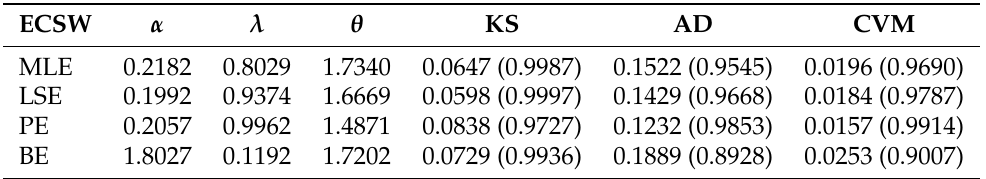
Table 1. MLE, LSE, PE, BE, KS, AD, and CVM with their p -value in parenthesis of the precipita- tion